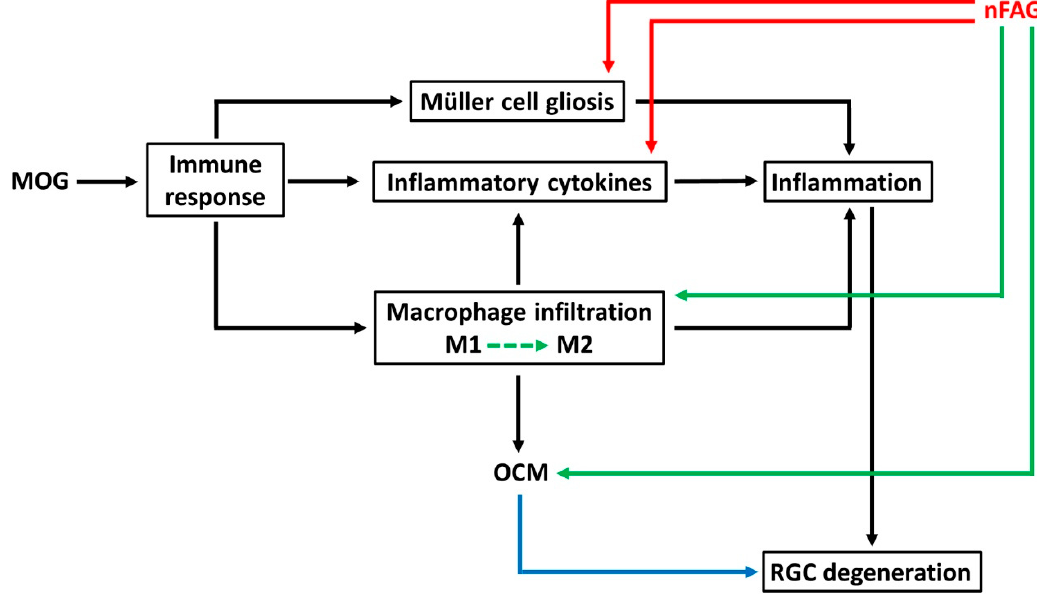
Figure 7. Schematic diagram depicting a possible mechanism of action of nFAG. MOG induces an immune response resulting in Müller cell gliosis, overproduction of inflammatory cytokines and macrophage infiltration. Infiltrating macrophages further activates inflammatory processes by producing potentially dangerous cytokines. The production of a pro-inflammatory niche likely induces RGC degeneration. Macrophages are also responsible for the production of oncomodulin (OCM), which would exert a trophic role on degenerating RGCs (blue arrow). nFAG reduces Müller cell gliosis and the overproduction of inflammatory cytokines (red arrows) thus substantially attenuating inflammatory processes. Having no effects on macrophage infiltration and OCM production (green arrows), the positive effect of OCM on neuroprotection and neuronal rescue would be preserved. We suggest the possibility that nFAG modulates the polarization of macrophages shifting them from a phenotype involved in inflammatory processes (M1) to a phenotype involved in neural repair (M2) therefore decreasing their pro-inflammatory activity, but proportionally increasing their tissue restoring capabilities (dotted green arrow).